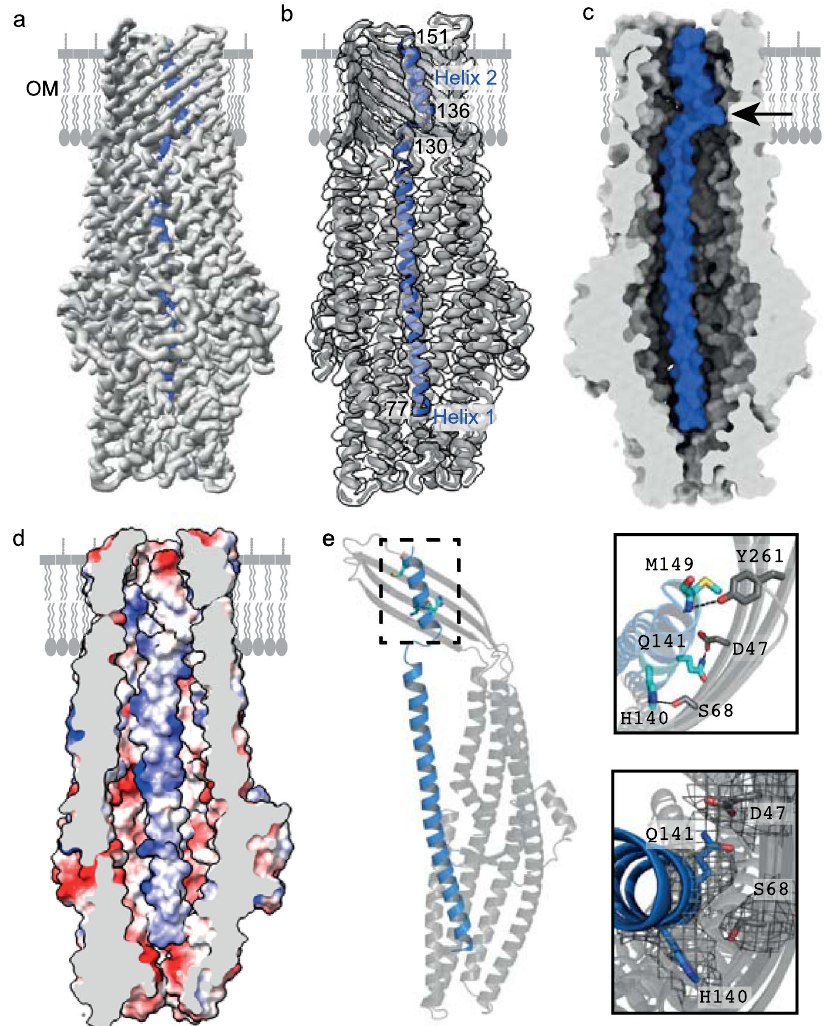
Fig. 2 KlebC1-254 binds within the lumen of the KqTolC trimer. a Single-particle cryo-EM map of the Kq TolC-KlebC 1-254 complex with KlebC 1-254 density (blue) resolved within Kq TolC (grey). The map resolution extends from 3 to 4 Å. b Cut through of Kq TolC-KlebC 1-254 complex map in panel a with the fi tted model, shows KlebC 1-254 density (blue) within the Kq TolC channel (grey). c Surface representation of the Kq TolC-KlebC 1-254 complex highlighting fi t of KlebC 1-254 in the lumen of Kq TolC. The shape of the Kq TolC channel combined with interactions between the helices of KlebC 1-254 and Kq TolC, result in KlebC 1-254 forming a kink (denoted by the arrow) in order to pass through the pore unobstructed. d Model of the electrostatic surface for the Kq TolC- KlebC 1-254 complex (the protein sequence for helix 1 is depicted in place of polyalanine used to solve the structure), highlighting the charge matching between the two proteins. Electrostatics generated in chimera. e Kq TolC chain C shown as a cartoon (grey) interacts with KlebC 1-254 (blue cartoon) helix 2. Insets show zoomed view of key interactions between Kq TolC chain C (grey sticks) and KlebC 1-254 (cyan sticks), which are localised predominantly to the N-terminal end of helix 2. Cryo-EM map density for modelled residues is shown as inset bottom